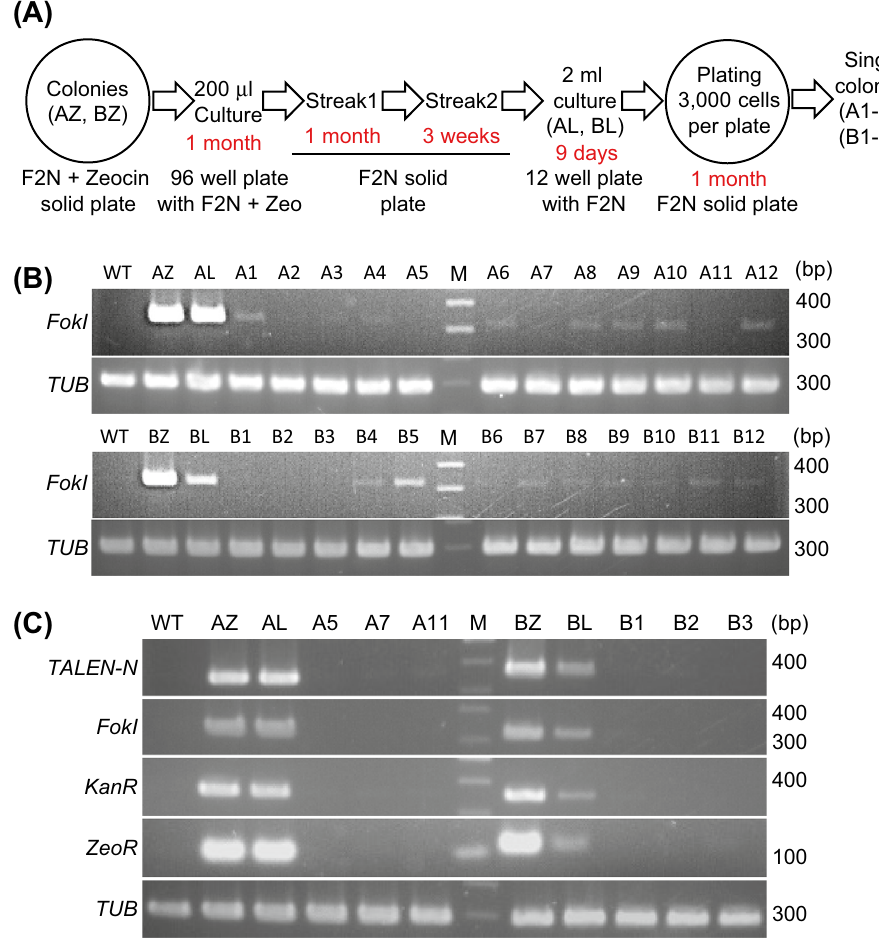
Figure 2. Clearance of all-in-one PtTALEN-ARS plasmids from Nannochloropsis oceanica cells. ( A ) Workflow for the clearance of all-in-one PtTALEN-ARS plasmids from host cells. All-in-one PtTALEN-ARS plasmids were removed by using F2N without zeocin solid plate or liquid medium. AZ and BZ are collected single colonies that emerged in a selectable zeocin plate following the introduction of all-in-one NoNR PtTALEN- ARS vectors. ( B ) Verification of all-in-one PtTALEN-ARS plasmid clearance by PCR using primers for amplification of FokI nuclease of TALENs. All-in-one PtTALEN-ARS plasmids clearance of strains collected from each clearing process was analyzed by using FokI primers, the internal plasmid sequence. FokI : FokI PCR amplicons; TUB : tubulin-beta PCR amplicons; WT: wild-type genomic DNAs; AZ and BZ: total DNAs from a single colony of N. oceanica that emerged in a selectable plate by the introduction of all-in-one NoNR PtTALEN- ARS plasmids; AL and BL: total DNA from AZ or BZ treated for plasmid clearance as shown in this figure; A1-A12 and B1-B12: total DNAs from single colonies that emerged in a solid F2N plate by spreading the AL or BL culture solution; M: DNA ladder marker. ( C ) Verification of all-in-one PtTALEN-ARS vector clearance by PCR using four pairs of primers for the detection of the all-in-one PtTALEN-ARS vector. The plasmid clearance of strains that were not detected FokI PCR bands was verified again using the other 3 pairs of internal plasmid primers. PtTALEN-N : PtTALEN N terminal domain PCR amplicons; FokI : FokI PCR amplicons; KanR : kanamycin resistance gene PCR amplicons; ZeoR : zeocin resistance gene ( ShBle ) PCR amplicons; TUB : tubulin- beta PCR